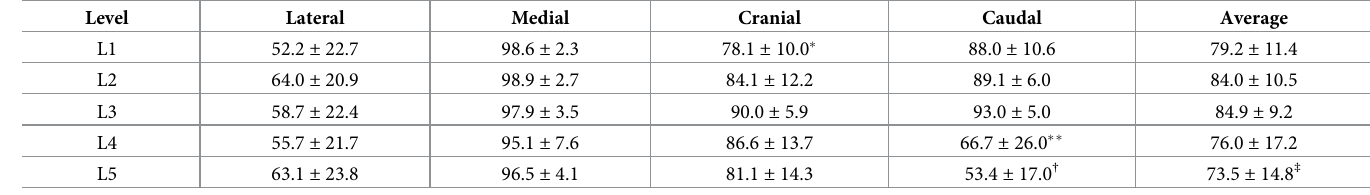
Table 4. Bone area fraction by spinal level (%, mean ±